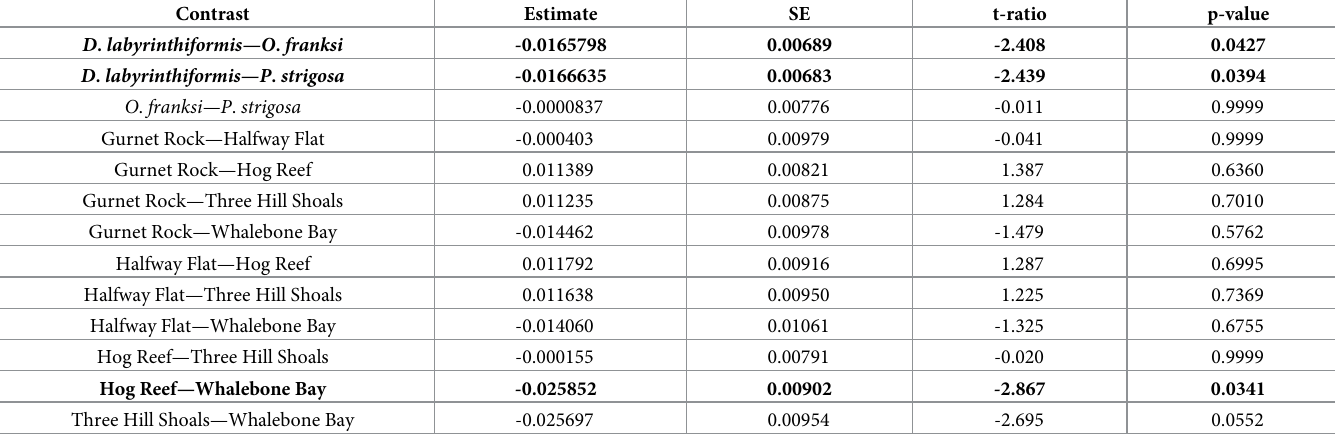
Table 3. Summary of Tukey Honest Significant Difference (HSD) pairwise comparisons of species and site for the best model to fit the annual calcification rate data.